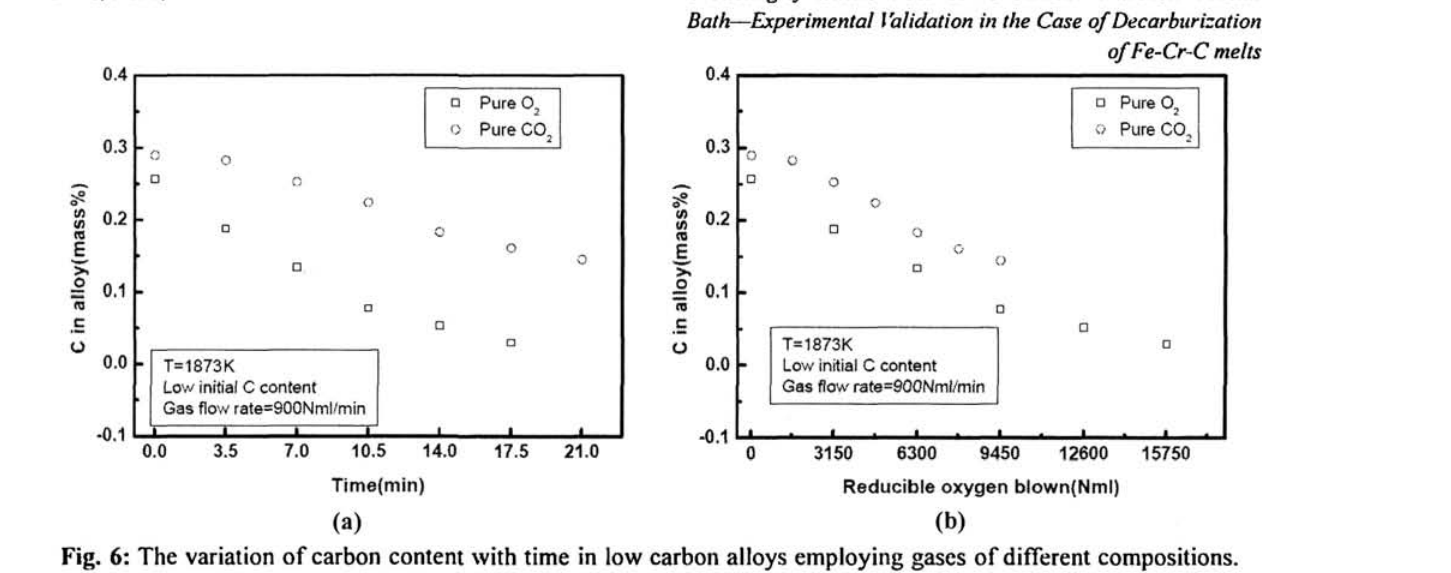
Fig. 6: The variation of carbon content with time in low carbon alloys employing gases of different compositions, (a) Injection rate =900NmI/min; (b) Injection rate =900Nml/min, but plotted against reducible oxygen blown, i.e., O + CO /2. 2 2